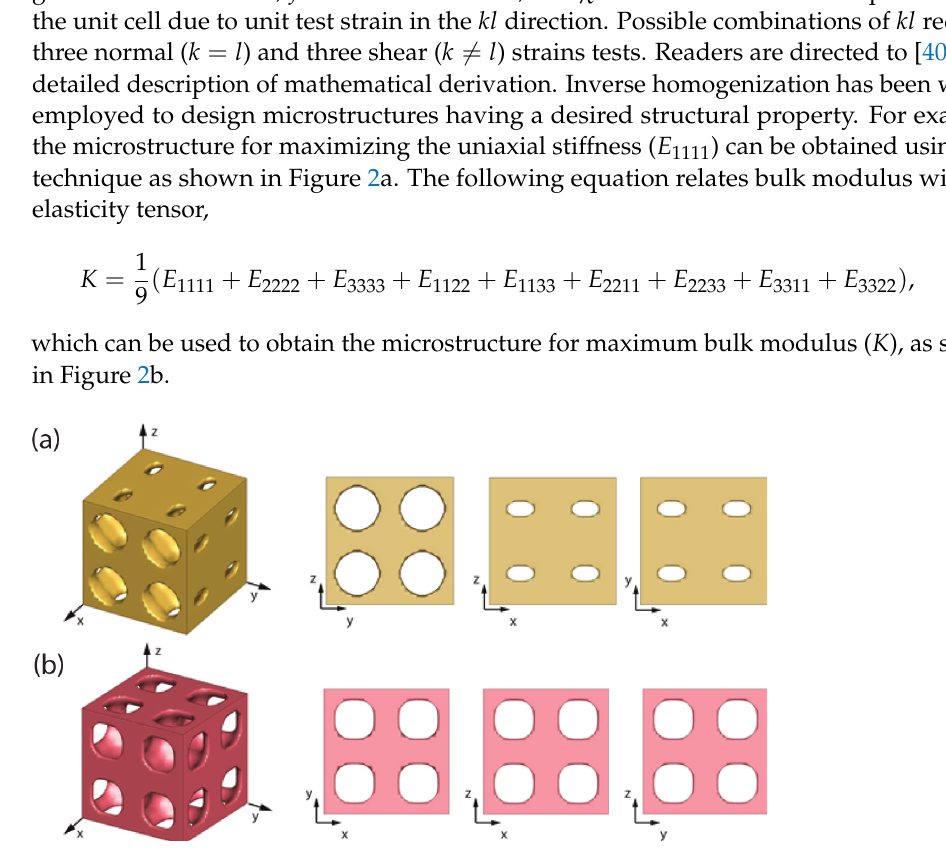
Figure 2. Design of microstructure using topology optimization. Maximization of ( a ) uniaxial ( x ) stiffness, and ( b ) bulk